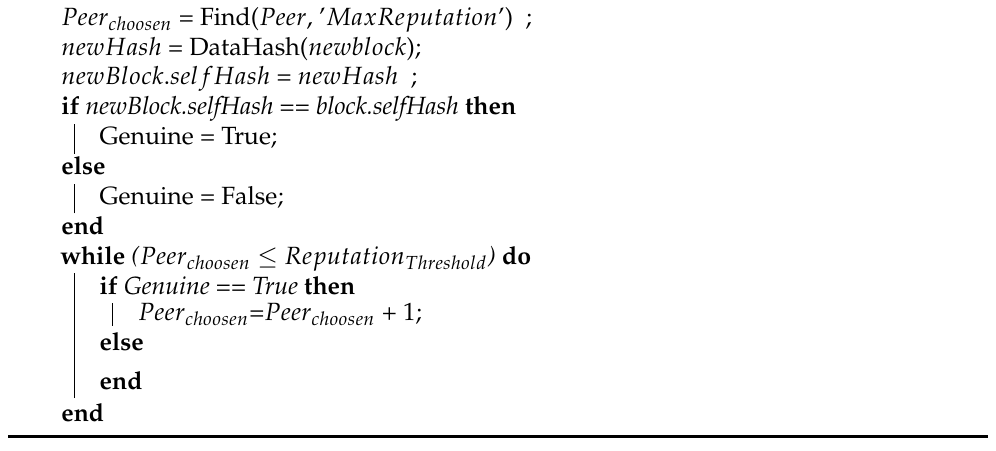
Algorithm 3 VerifyNewblock using PoT